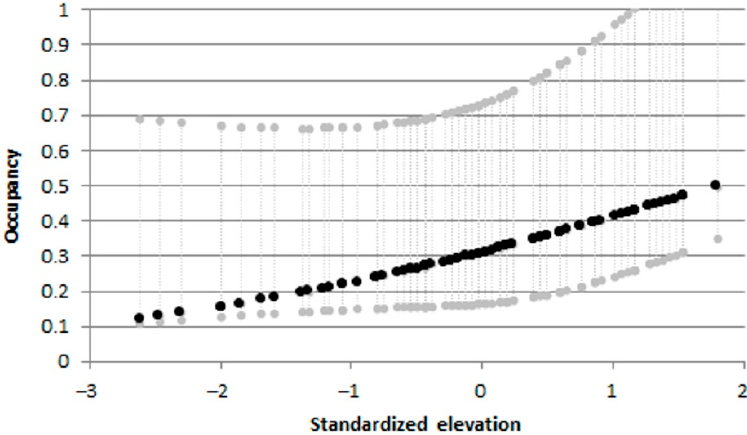
Figure 13. Pseudorasbora parva : effects of elevation on occupancy from the best informative models. Dashed gray lines indicate upper and lower 95% confidence intervals.